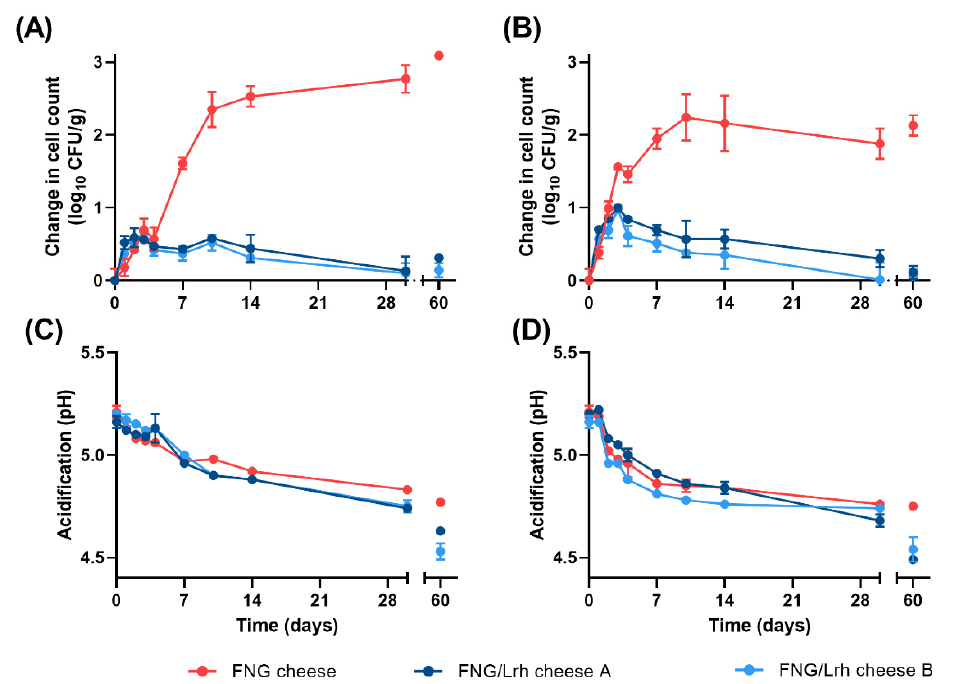
Figure 1. Growth of L. monocytogenes and development of pH in cottage cheese prepared with or without Lrh-FQ. Shown are the changes in L. monocytogenes CFU/g compared to Day 0 as detected in FNG or FNG/Lrh-FQ cottage cheeses after PMO ( A ) or industrial ( B ) cooling, and corresponding acidification curves of the cheeses after PMO ( C ) or industrial cooling ( D ). Shown are averaged values obtained from measurements in three cheeses per condition. FNG/Lrh-FQ cottage cheese A and B are biological replicates, produced in separate vats with different FNG and Lrh-FQ lot numbers.